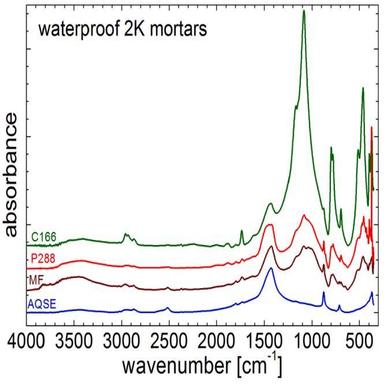
The FT-IR spectra for MF, C166, AQSE and P288 mortars.